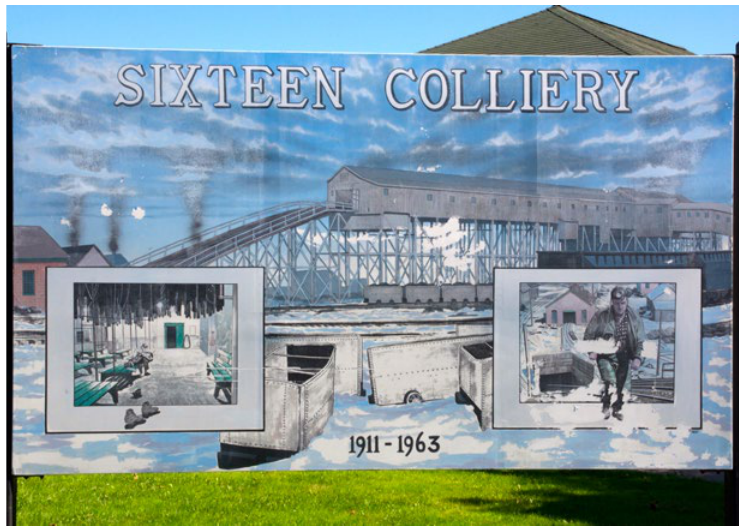
Figure 7. Number 16